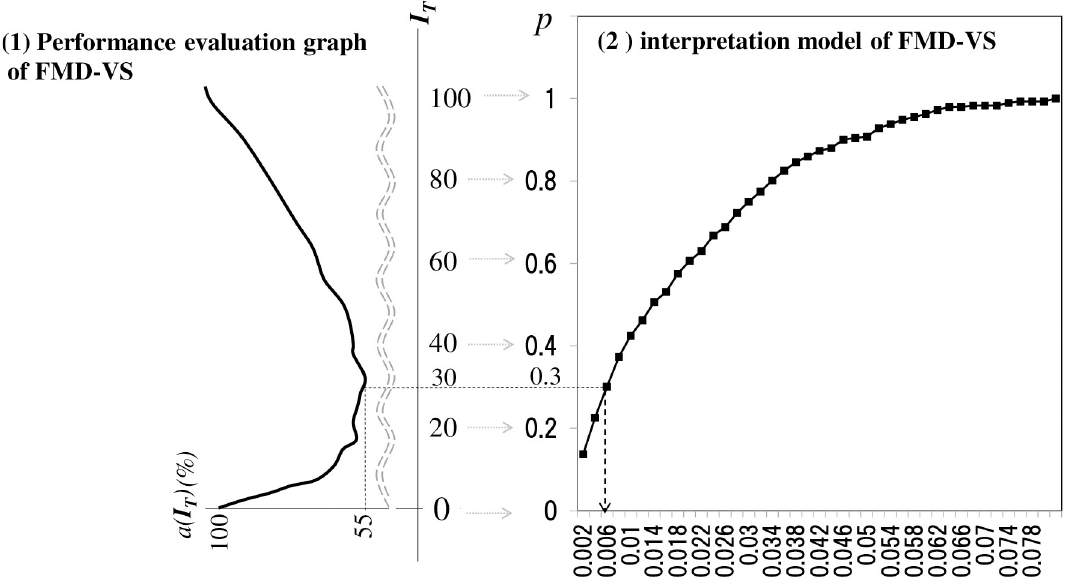
Fig 3. Purpose of the FMD-VS performance evaluation graph. For example, the minimum a(I evaluation graph associates threshold I T = 30 ! probability p = 0.3 ! scattering index λ = 0.006. This means that we were able to confirm (from the actual data) that, in 55% of the cases, a farm changed to infectivity when the threshold value of 30 was reached, or, more importantly, at a time when its scattering index first exceeded